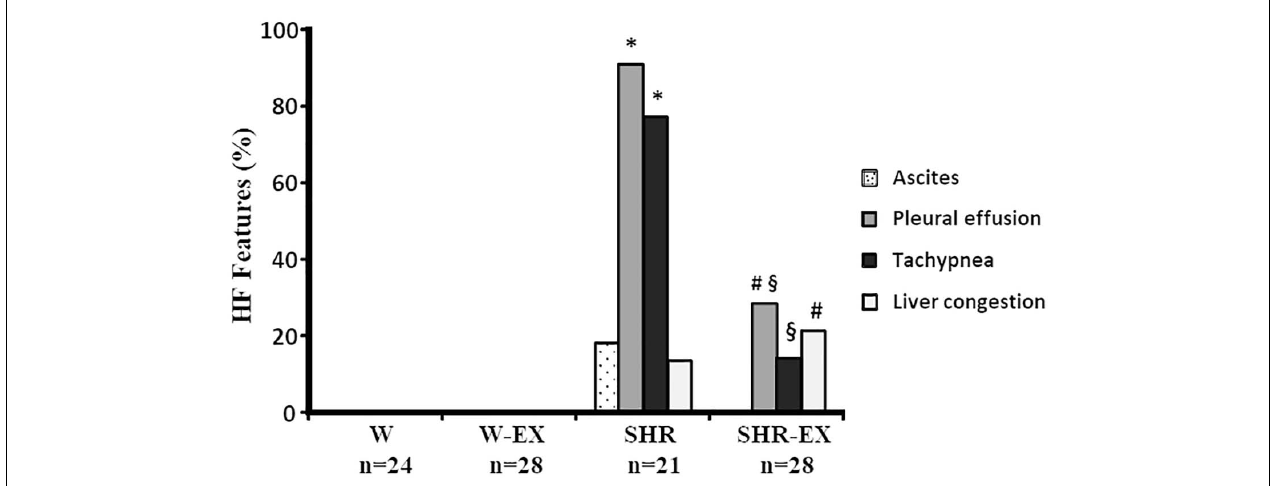
FIGURE 1 | Heart failure (HF) feature frequencies. W: Wistar rats; W-EX: exercised Wistar rats; SHR: spontaneously hypertensive rats; SHR-EX: exercised SHR. Goodman test; ∗ p < 0.05 vs. W; # p < 0.05 vs. W-EX; § p < 0.05 vs. SHR.